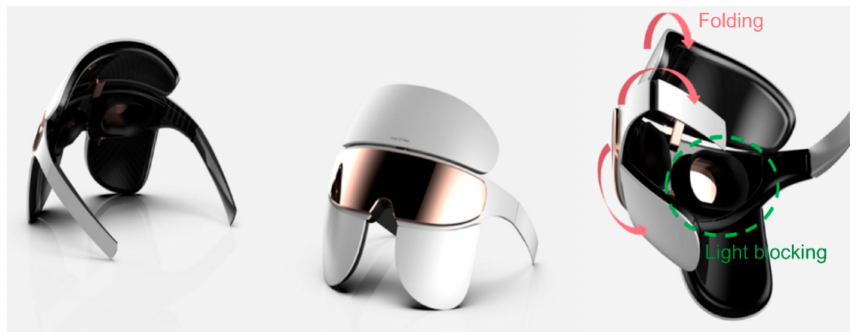
Figure 8. Second LED-mask design